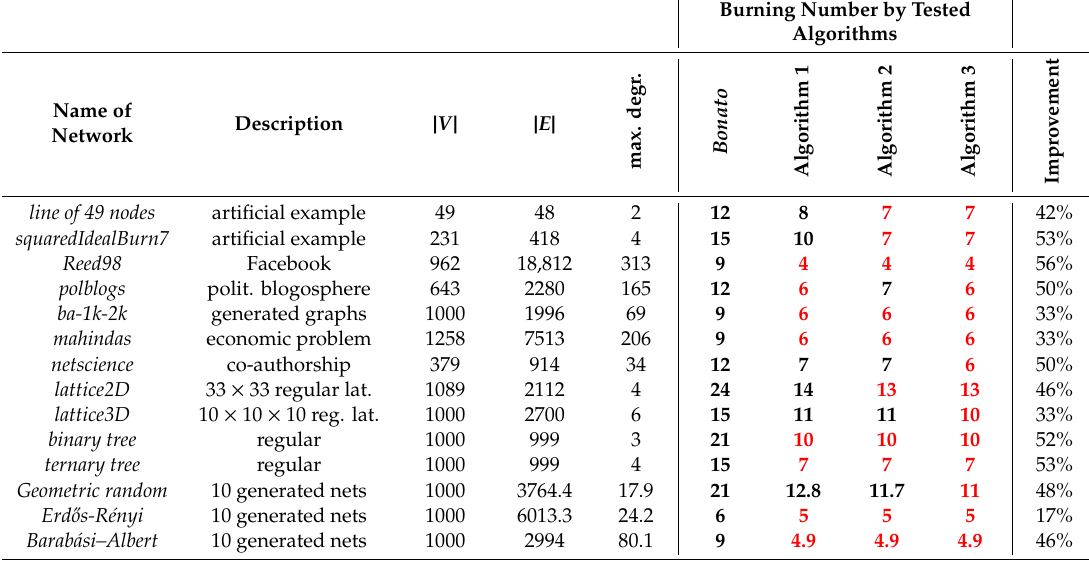
Table 1. Burning number results for tested networks and